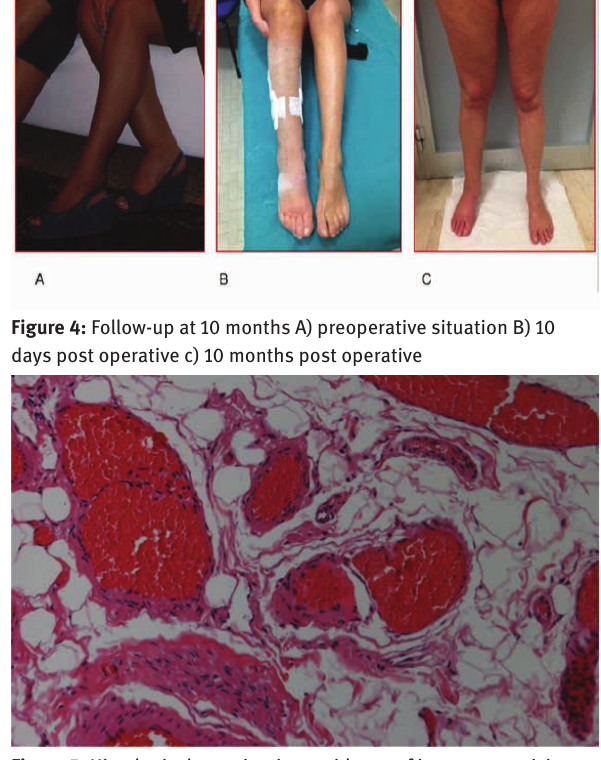
Figure 5: Histological examination: evidence of immunoreactivity of the muscle cells for actin and myosin dependent of lymphatic